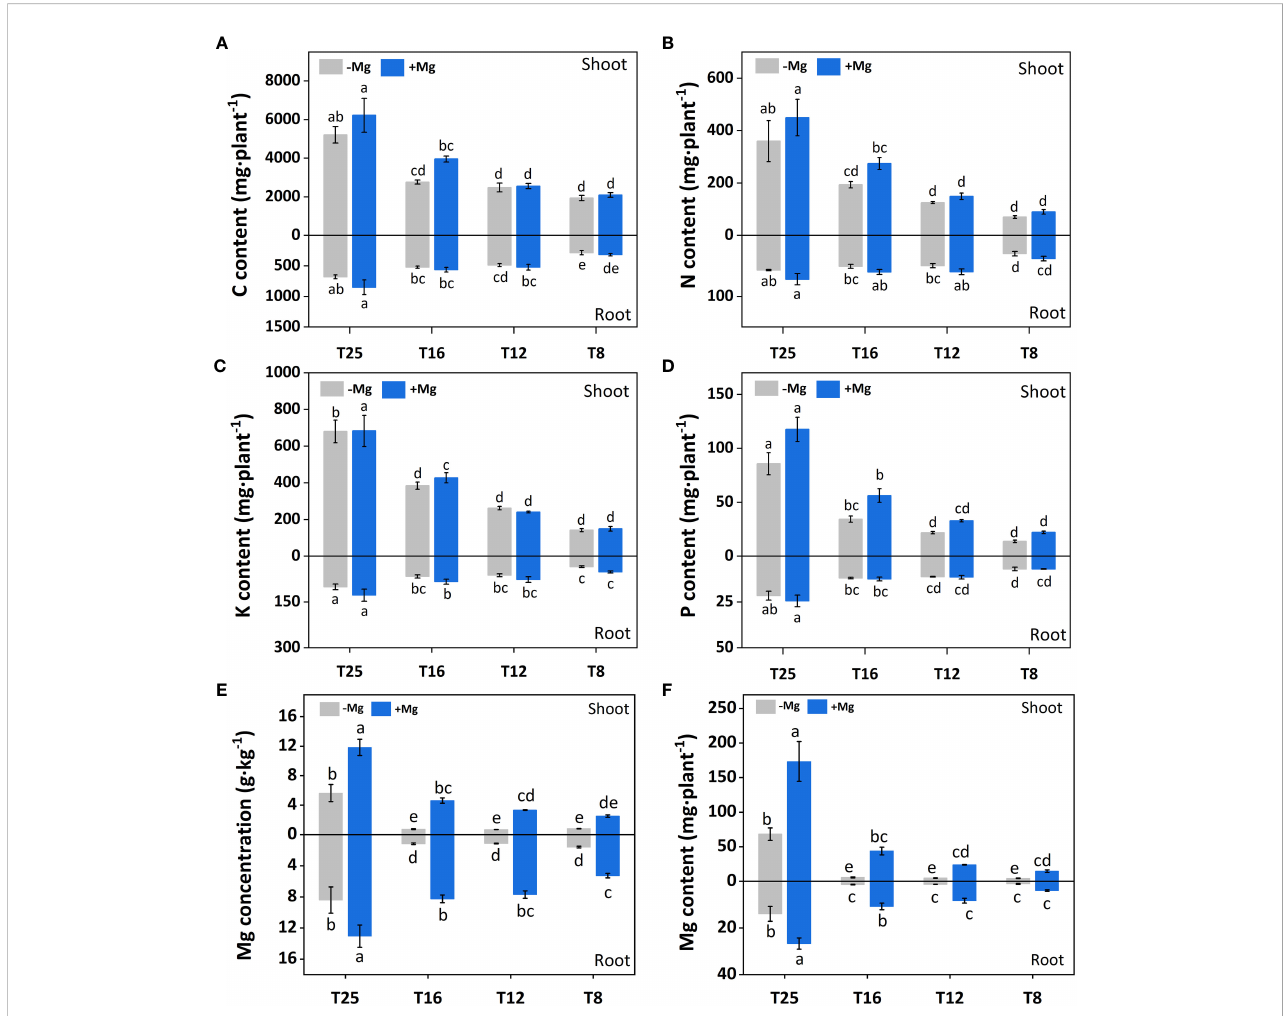
FIGURE 3 Effect of Mg application on concentration of minerals nutrients under different temperature in tobacco plant. (A) shoot-C content and root-C content; (B) shoot-N content and root-N content; (C) shoot-K content and root-K content; (D) shoot-P content and root-P content; (E) shoot-Mg concentration and root-Mg concentration; (F) shoot-Mg content and root-Mg content. The different letters above the bars are indicating signi fi cant difference (Duncan P